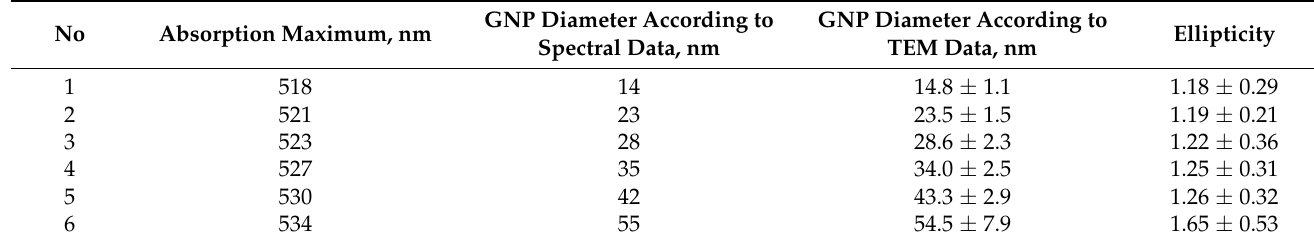
Table 1. Dimensional and spectral characteristics of GNPs.